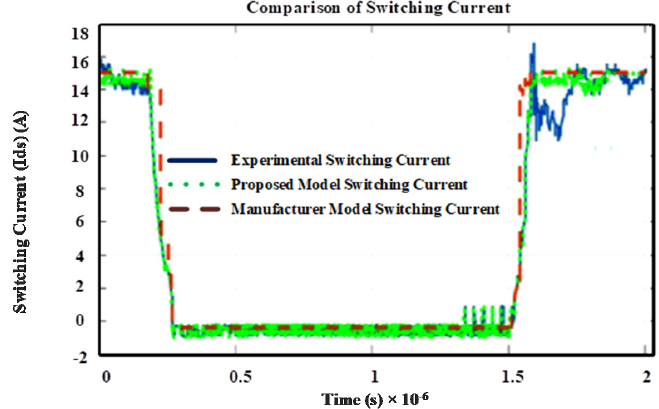
Figure 19. Comparison of switching current waveforms of models with DPT results.